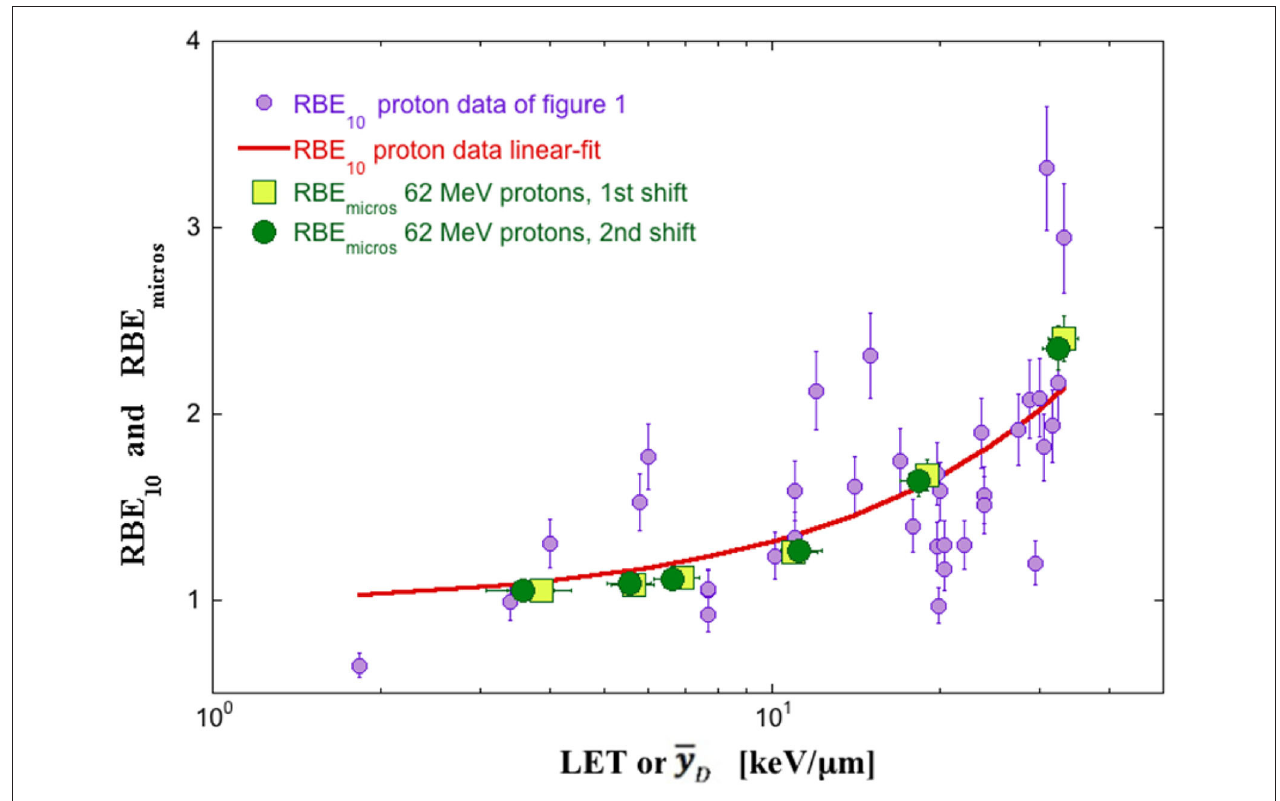
FIGURE 8 | The relative biological effectiveness microdosimetric assessment ( RBE micros ) (squares and circles) vs. measured y D [mini-tissue-equivalent proportional counter (TEPC) measurements in 1- µ m site at the 62 MeV proton beam of CATANA] and RBE 10 (violet circles) vs. calculated linear energy transfer ( LET) values. The red line is the linear best fit of RBE 10 data. Squares and circles point out two different shifts of measurements 4 months apart. Data from ICRU [ 29].